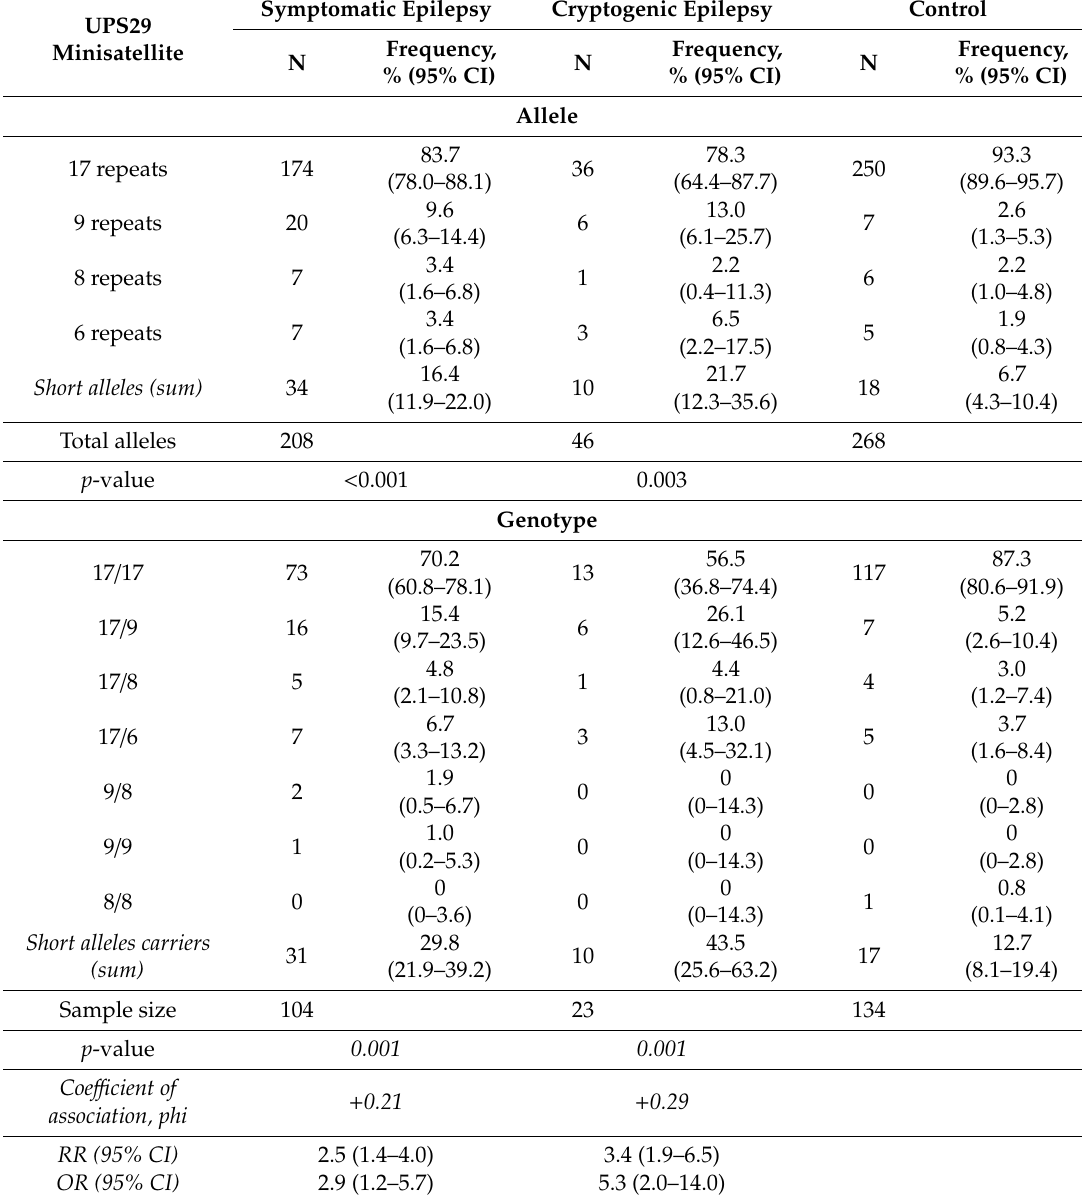
Table2. AlleleandgenotypefrequencyofUPS29inwomenwithepilepsy(symptomaticandcryptogenic) compared with healthy